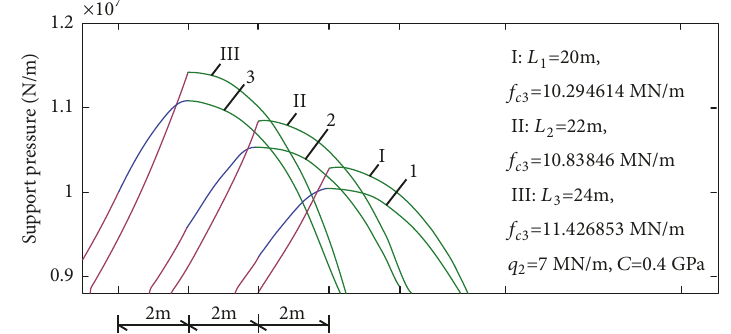
Figure 11: Enlarged drawings at peak part of support pressure with the increasing of the distance of overhang roof.